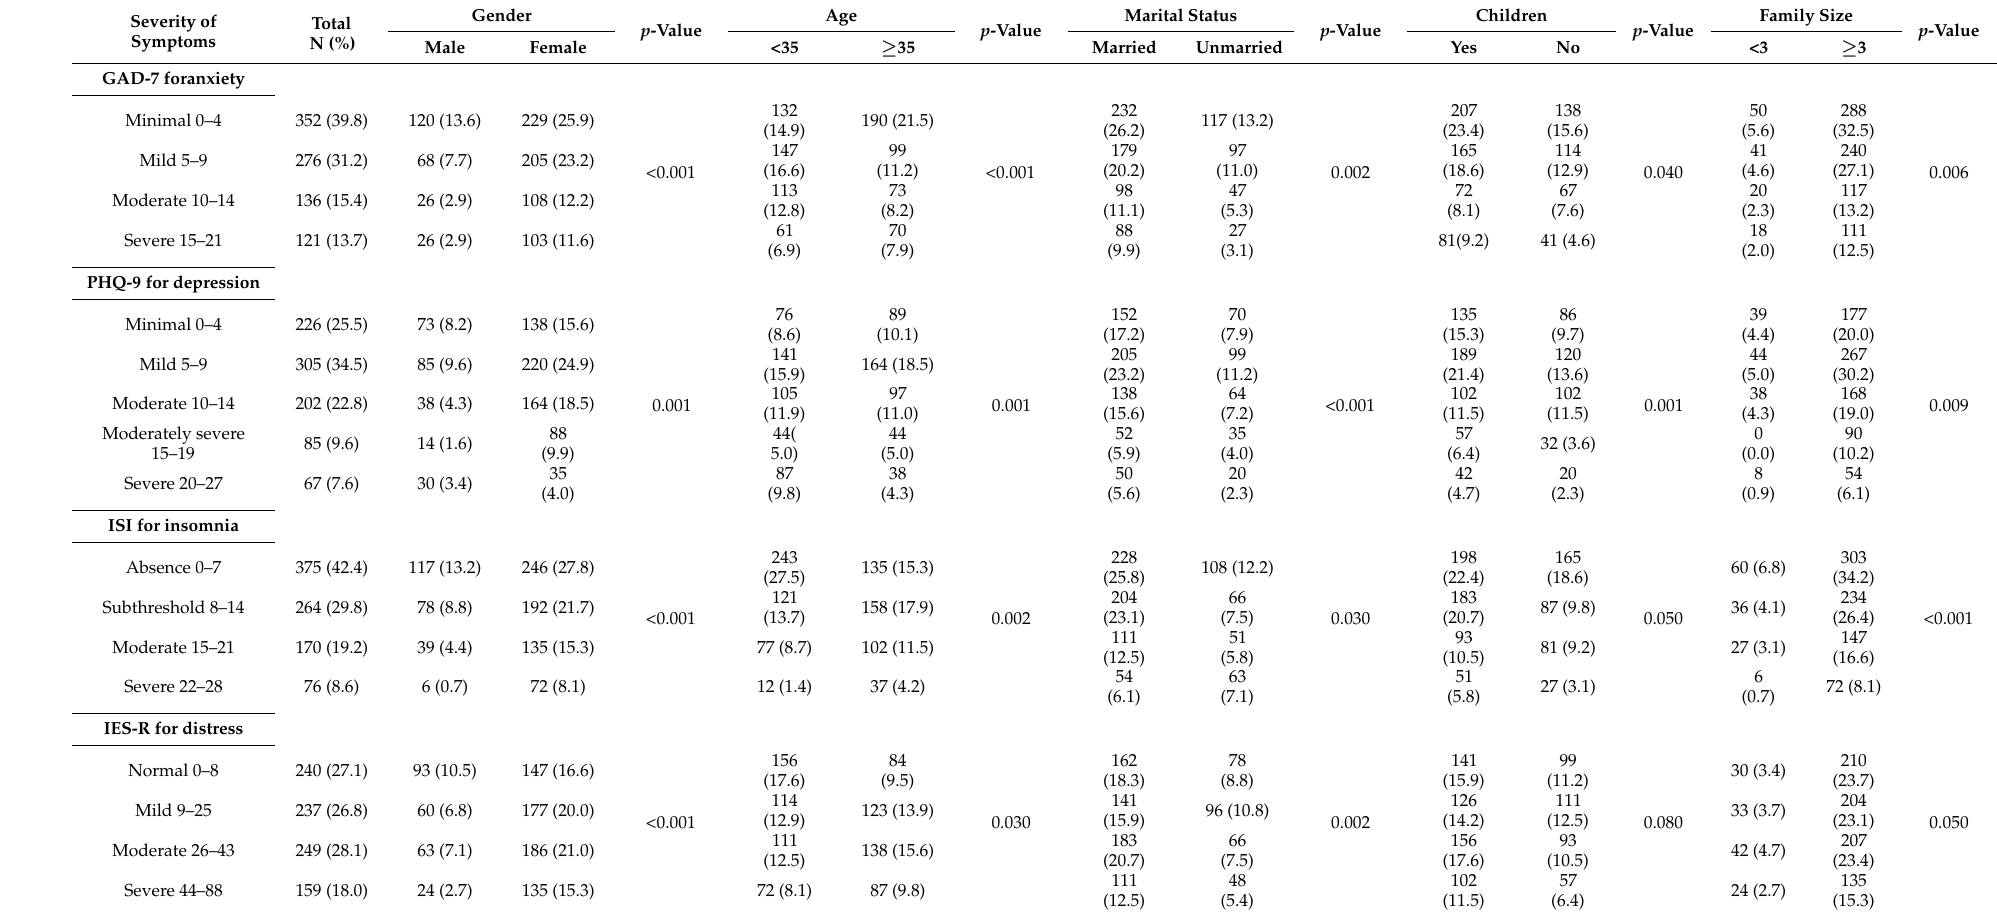
Table 2. Severity of anxiety, depression, insomnia and distress symptoms in the general population and among different